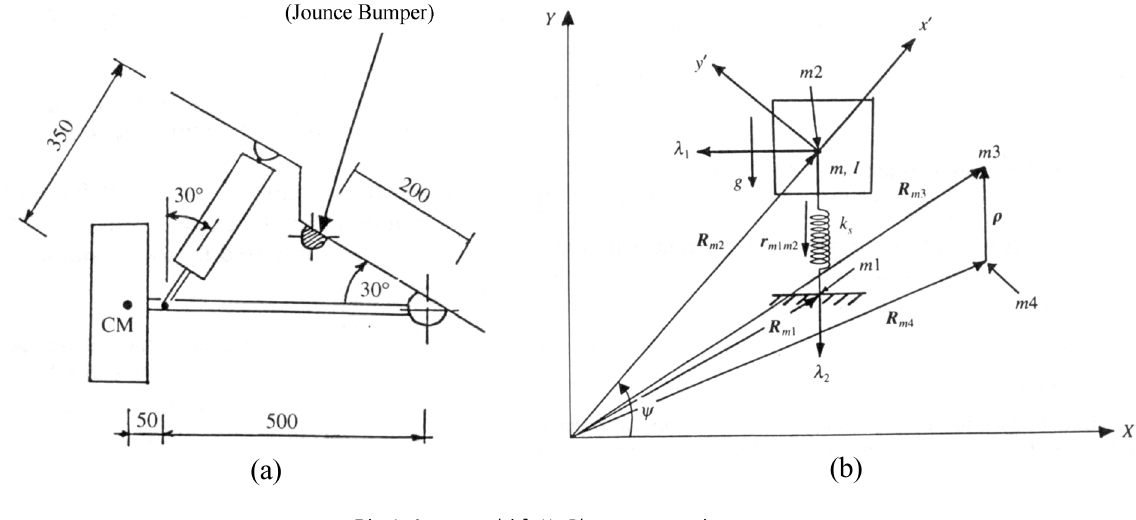
Fig. 1. Quarter vehicle McPherson suspension